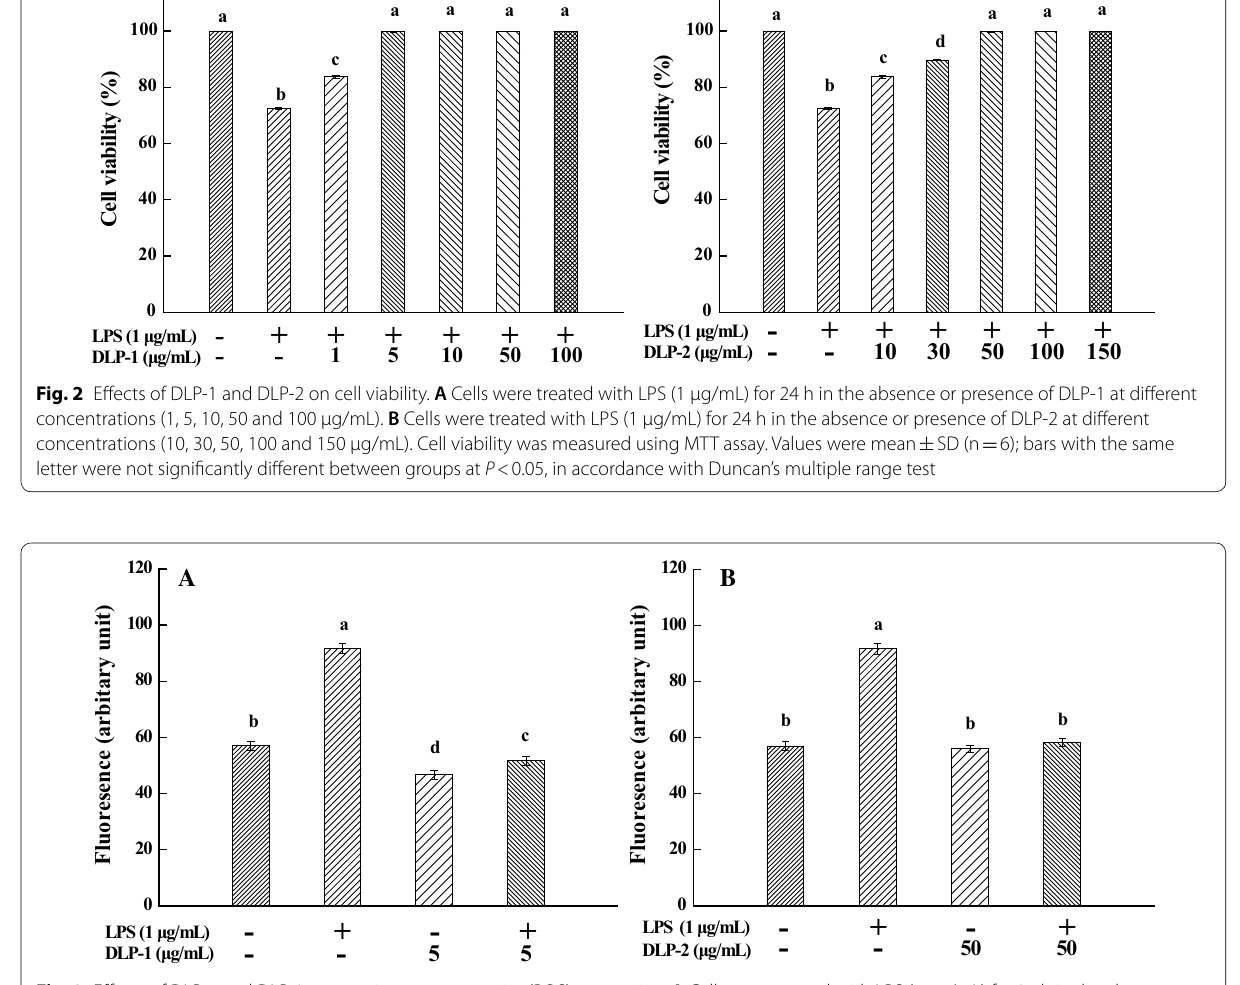
Fig. 3 Effects of DLP-1 and DLP-2 on reactive oxygen species (ROS) generation. A Cells were treated with LPS (1 μg/mL) for 24 h in the absence or presence of DLP-1 (5 μg/mL). B Cells were treated with LPS (1 μg/mL) for 24 h in the absence or presence of DLP-2 (50 μg/mL), followed by addition of 10 μM DCFH-DA to incubate for 30 min. Values were mean accordance with Duncan’s multiple range test